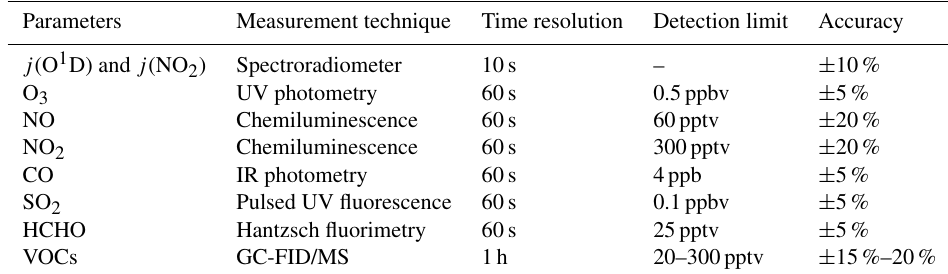
Table 2. Instruments deployed in the field campaign undertaken in August 2012 and used for data analysis.